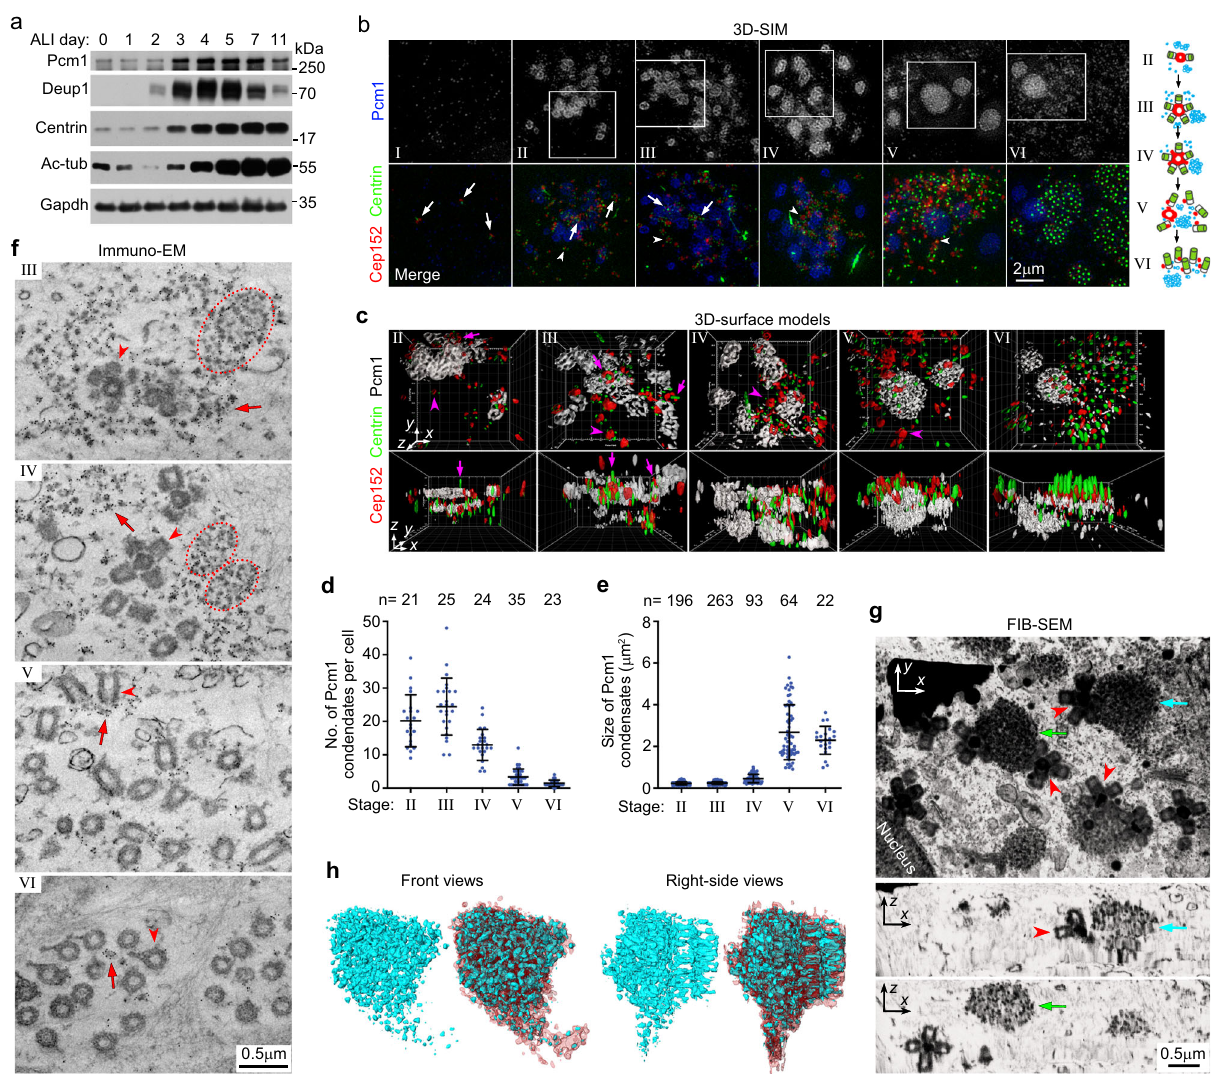
Fig. 1 Pcm1 decorates loose FGMs and tight FGM cores in mTECs undergoing centriole ampli fi cation. a Expression pattern of Pcm1 during mTEC differentiation. mTECs were induced to differentiate into MCCs by culturing at an air-liquid interface (ALI). Total cells collected at the indicated days were used for immunoblotting. Deup1, Centrin, and acetylated tubulin (Ac-tub) were used to indicate the abundance of deuterosomes, centrioles, and cilia, respectively 8 . Gapdh served as loading control. Two biologically independent experiments were performed and images from the same experiment were presented. b , c Subcellular distribution of Pcm1 in different stages (I – VI) of the centriole ampli fi cation. Presented are typical z-projected 3D-SIM (three dimensional structured illumination microscopy) images of mTECs at day 3 ( b ) and the top and side views of 3D reconstructions ( c ) for the framed regions. Cep152 decorated parental centrioles (arrows), deuterosomes (arrowheads indicating typical ones), and, in stages V – VI, a spot at the proximal side of the nascent centrioles or basal bodies in mTECs 8 . Centrin served as a centriole marker. Diagrams in b illustrate typical localization patterns of the proteins during the indicated stages of the deuterosome-mediated centriole biogenesis de fi ned previously 8 . Brie fl y, deuterosomes start to form in stage II and are enlarged in stage III; the deuterosomal Cep152 displays radial appendages in stage IV; nascent centrioles are released from deuterosomes in stage V, followed by their apical polarization, clustering, and ciliogenesis in stage VI. d , e Quanti fi cations on the number ( d ) and size ( e ) of the Pcm1 condensates. At least 21 cells from two independent experiments were scored. Both sample dots and mean ± s.d. are presented. f Immuno-electron microscopy (Immuno-EM) con fi rmed the presence of Pcm1 in loose FGMs (arrows) and FGM cores (circles). mTECs at ALI day 3 were immuno-labeled with 10-nm gold particles. Arrowheads indicate typical deuterosome-procentriole complexes (stages III and IV) or basal bodies (stages V and VI). Immuno-EM experiments were performed once. g , h FGM cores appeared as porous condensates of interconnected FGs. Serial z-stack mTEC images acquired by FIB- SEM (Focused Ion Beam Scanning Electron Microscope) were 3D reconstructed (Supplementary Movie 1) and presented as the top view and two digital z-sections at the arrow-indicated positions ( g ). The arrowheads indicate deuterosome-procentriole complexes spatially adjacent to FGM cores. The structural information for the FGM core pointed by the blue arrow ( g ) was segmented for a 3D view (Supplementary Movie 2) and present as side views ( h ). The high electron-dense FGs were rendered blue and their surrounding less electron-dense materials red. Note that the bottom region contains loosely packed FGMs, possibly in the process of assembly into or disassembly from the core. Two biologically independent experiments were performed. Source data are provided in the Source data fi